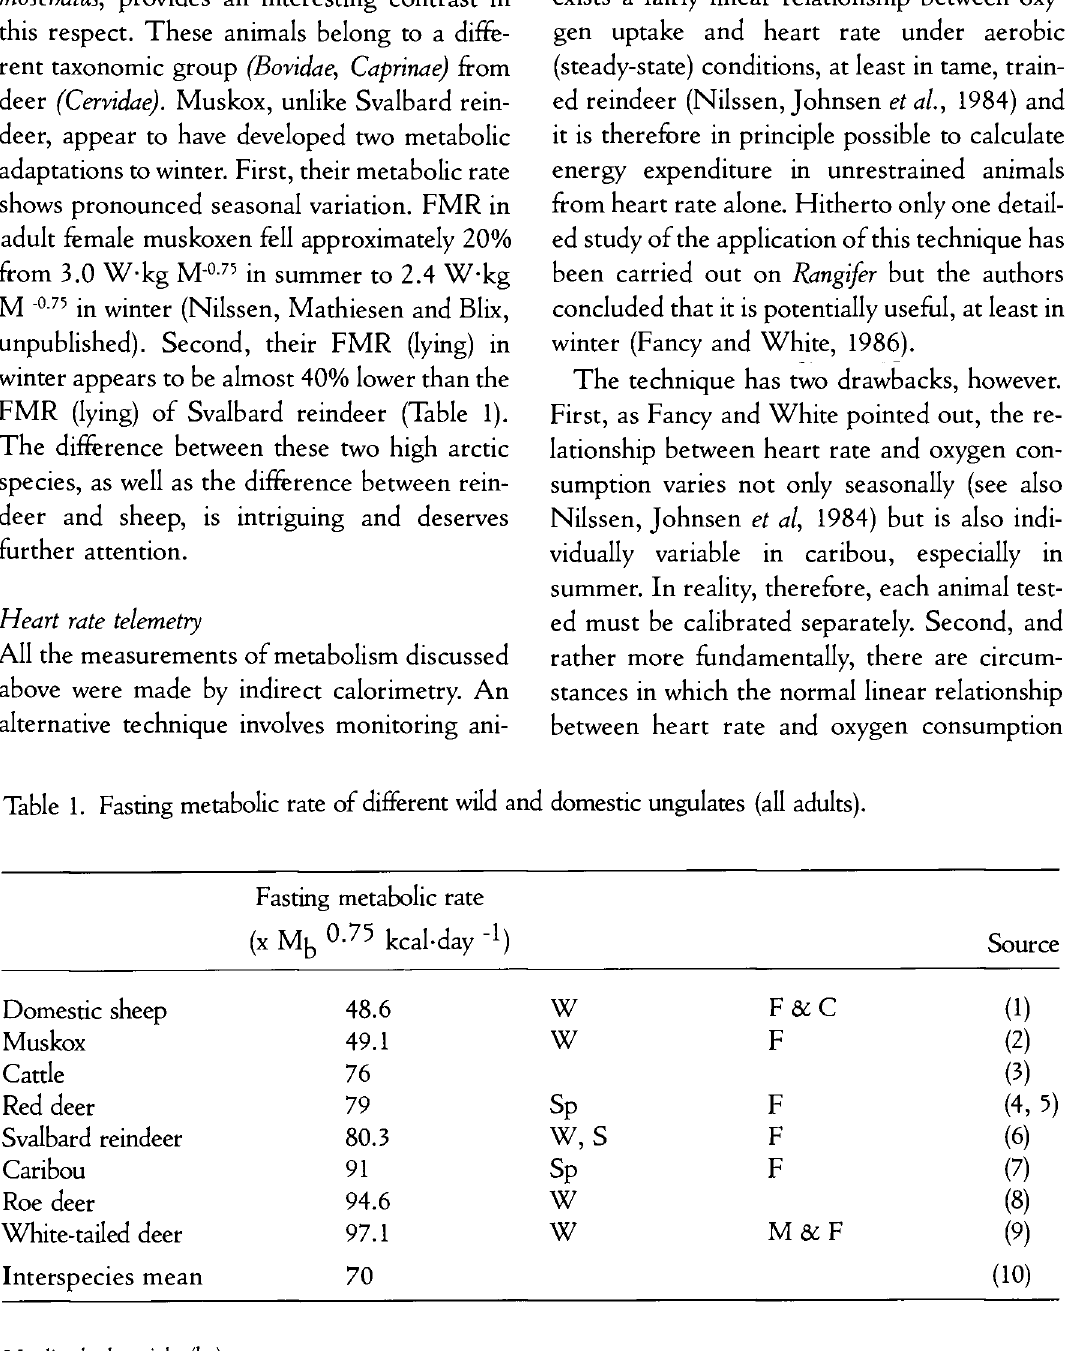
Table 1. Fasting me :tabolic rate of different wild a nd domestic unj ^ulates (all adults).